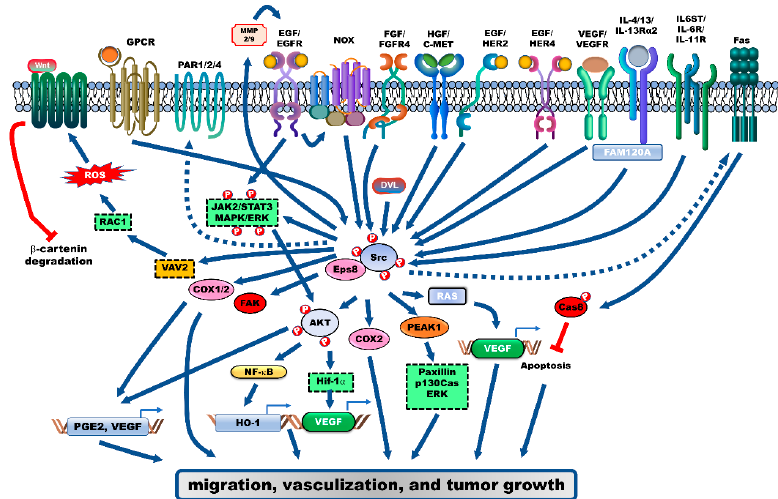
Figure 1. Receptor-mediated signaling pathways that activate Src during the progression of colorectal cancer (CRC). Several receptor-mediated signaling pathways activate Src, which plays an essential role in the progression of CRC. Src is activated by the ligand / receptor signaling complexes, including EGF / EGFR, HGF / c-MET, VEGF / VEGFR, FGFR, IL4 / IL-13R α 2, and IL6 / IL-11 signaling pathways, which further activate their downstream target signaling pathways, such as the AKT / NF- κ B / HO-1, MAPK / ERK, and other oncoproteins to enhance proliferation, vascularization, and metastasis of CRC cells. Further, several G-coupled protein receptors (GPCRs) are involved in CRC progression through the activation of Src-mediated signaling pathways. PGE2 / EP1, PARs, and CCK 2 R enhance cell proliferation by activating the EGFR / Src / MAPK / ERK and HIF-1 α / Src / AKT / VEGF signaling axis. Additionally, the activation of Wnt- β -catenin signaling by Src-induced Rac1, which enhances reactive oxygen species (ROS) generation, results in enhanced migration of CRC